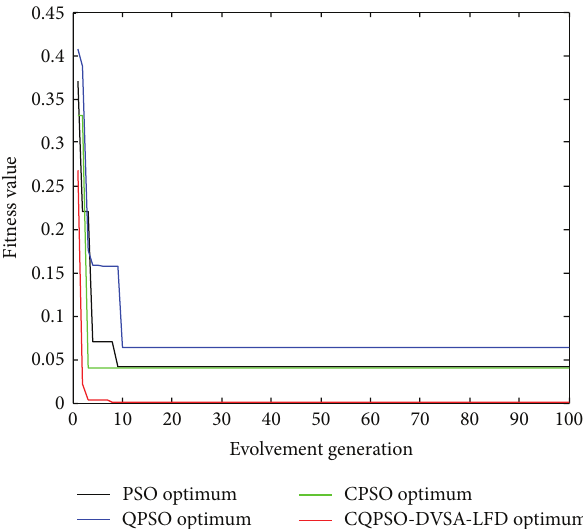
Figure 6: Evolution curves of Griewank function.